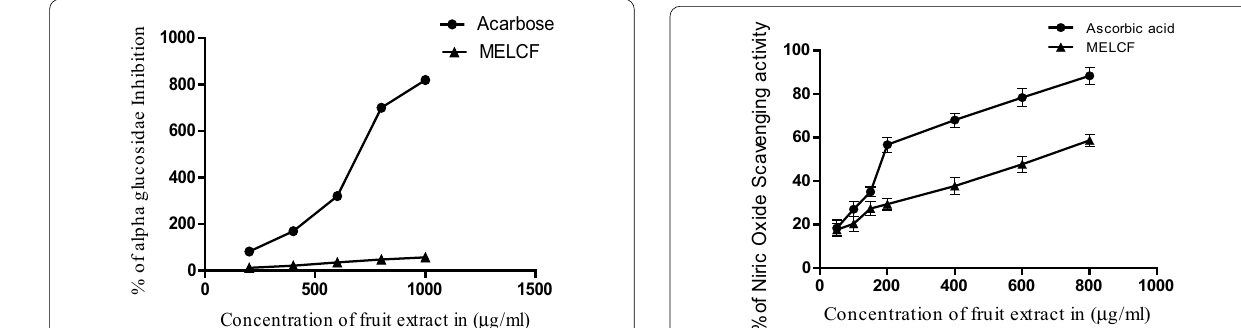
Fig. 4 In vitro nitric oxide scavenging activity of ascorbic acid and MELCF. The values are represented as an average of triplicate trials, the error bars are SEM